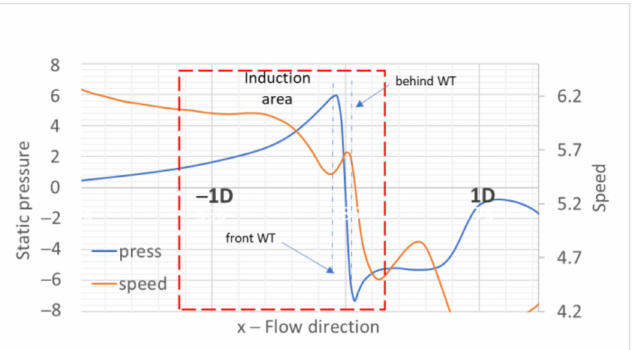
Figure 7. The pressure and speed in the induction zone and over the rotor for the second turbine in line—distance from the first turbine is 4.5 rotor